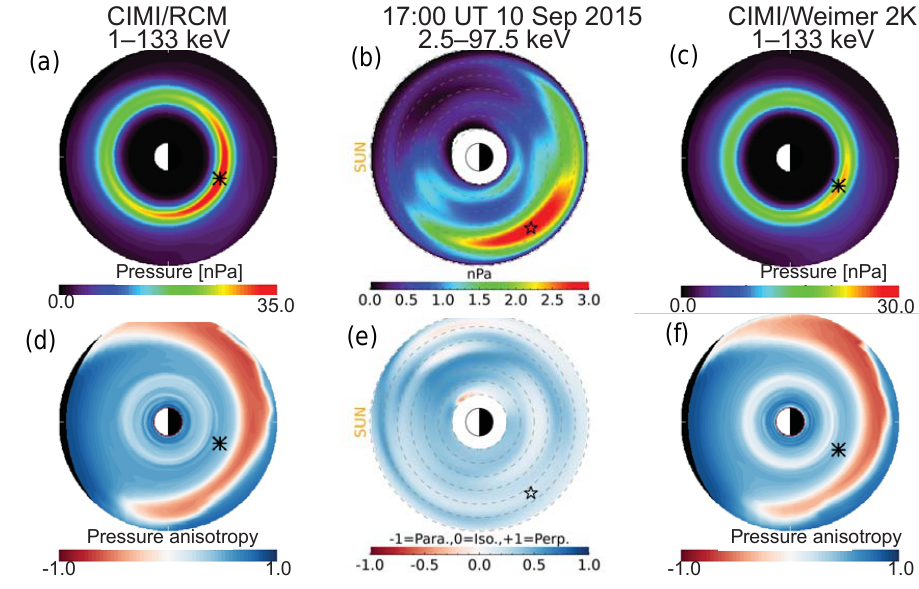
Figure 9. The ion equatorial pressure and pressure anisotropy for 17:00UT 10 September 2015 in the same format as Fig. 3.